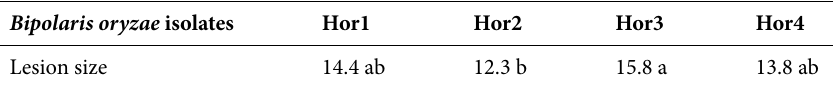
Table 2 e degree of lesion on Typha latifolia leaves at 7 days aer inoculation with the conidial suspension of each isolate of Bipolaris oryzae (mm).